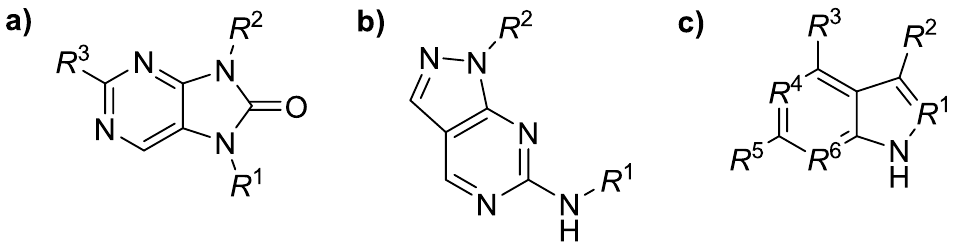
Figure 1. General structure of Janus kinase inhibitors containing a variously substituted ( a ) purinone, ( b ) pyrazolopyrimidine or ( c ) benzimidazole scaffold.